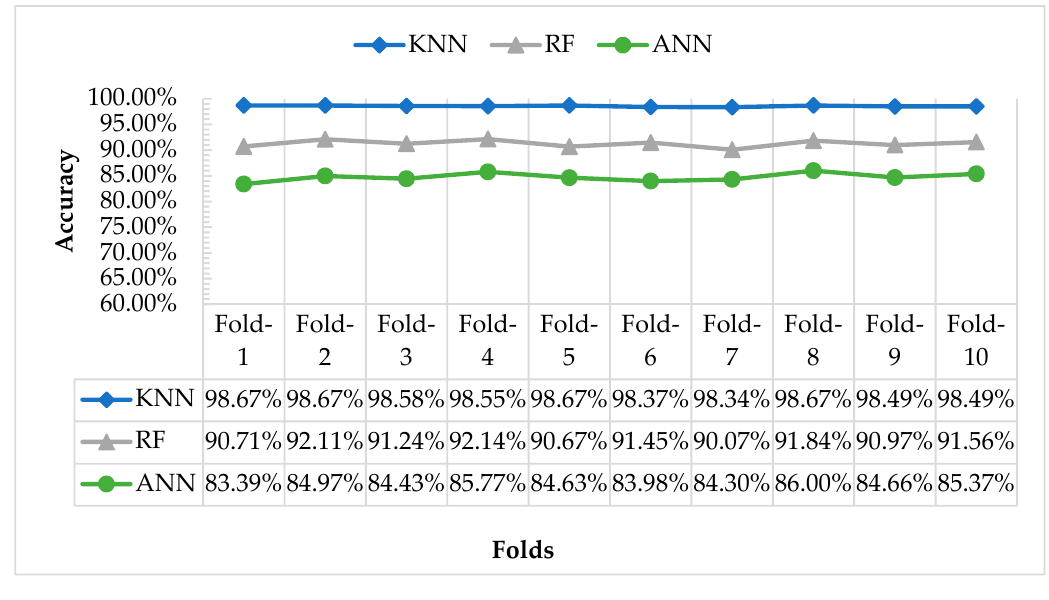
Figure 11. The comparison of 10-fold cross-validation accuracy.